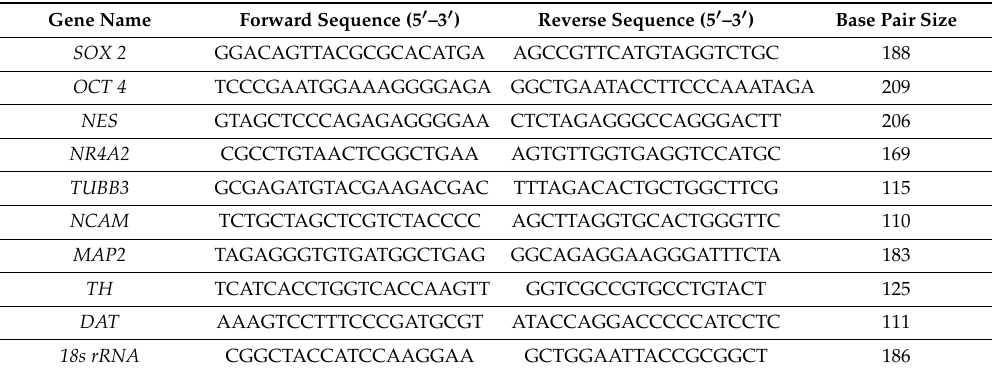
Table 1. List of genes with primer sequence and their product